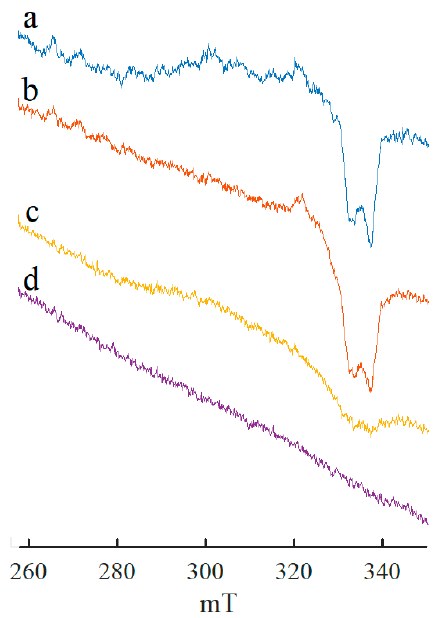
Figure 6. EPR spectra of the Co(acac) 2 –AlEt 3 catalytic system formed in toluene in a hydrogen at- mosphere: ( a ) 0.1–1 min, ( b ) 1–2 min, ( c ) 2–3 min, and ( d ) 4 min. Spectra were obtained under iden- atmosphere: (a) 0.1–1 min, (b) 1–2 min, (c) 2–3 min, and (d) 4 min. Spectra were obtained